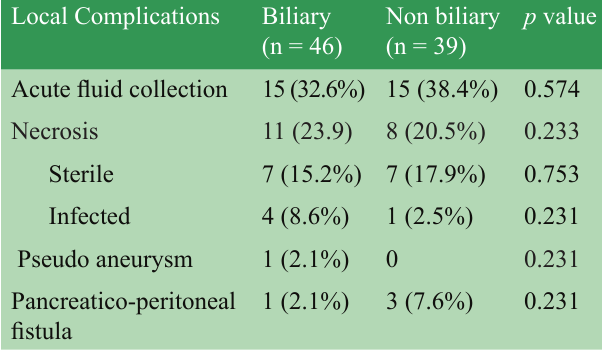
Table 5: Incidence of local complications in Biliary